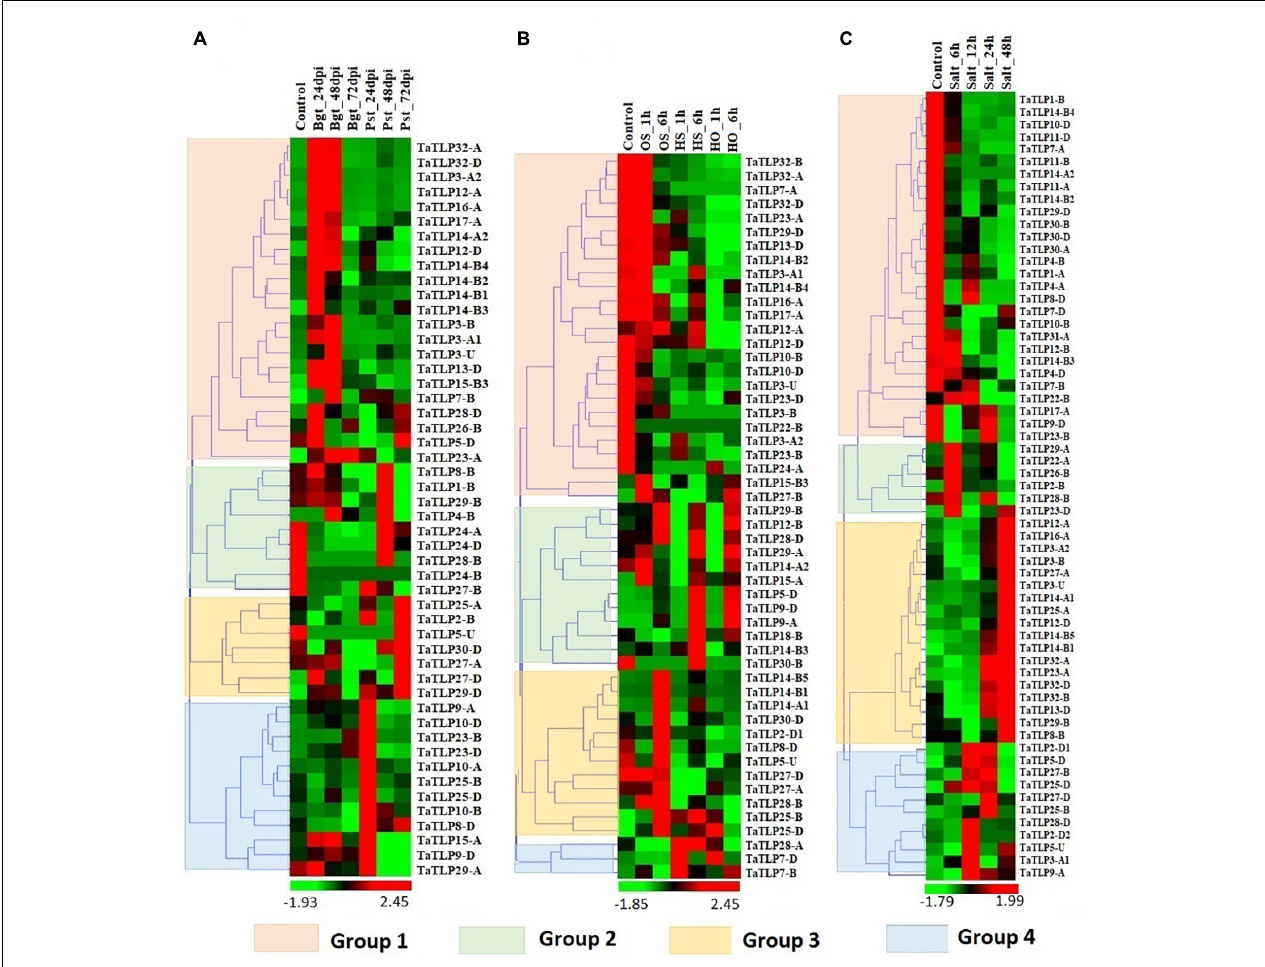
FIGURE 6 | Expression profiling of TLP genes of T. aestivum under biotic and abiotic stress conditions. Heat maps (A–C ) show the clustering and expression profiling of TaTLP genes under (A) Blumeria graminis (Bgt) and Puccinia striiformis (Pst), (B) heat (HS), osmotic (OS), and combined heat and osmotic (HO), and (C) salt stress conditions. The clustering of TaTLP genes in each heat map is based on their expression pattern in respective stress conditions. The color bar shows high and low expressions with red and green colors,